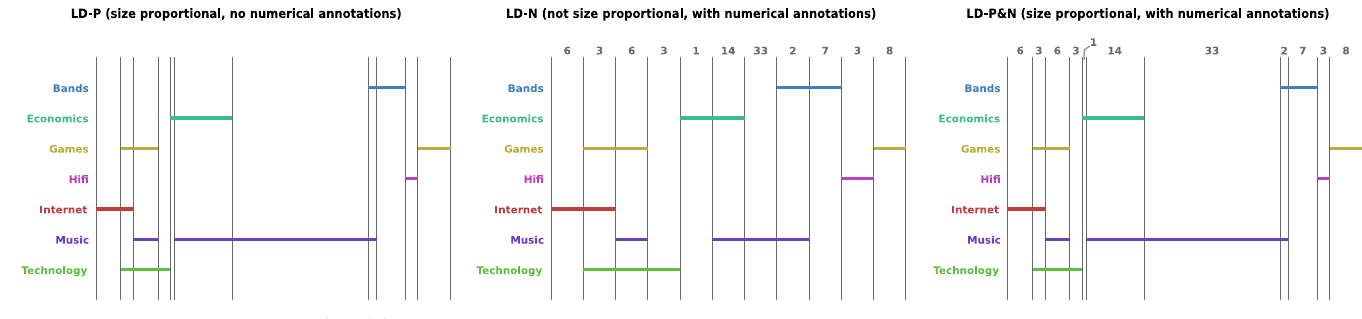
Fig 3. Linear diagrams, data set 32. (from left: LD-P, LD-N, LD-P&N).